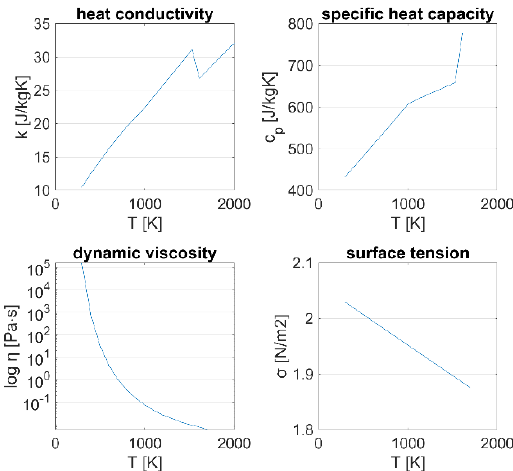
Figure 3. Temperature-dependent material properties of Inconel 718 from the COMSOL Multiphysics material library, Pottlacher et al. [12], Hosaeus et al. [13], and Overfelt et al. [14].